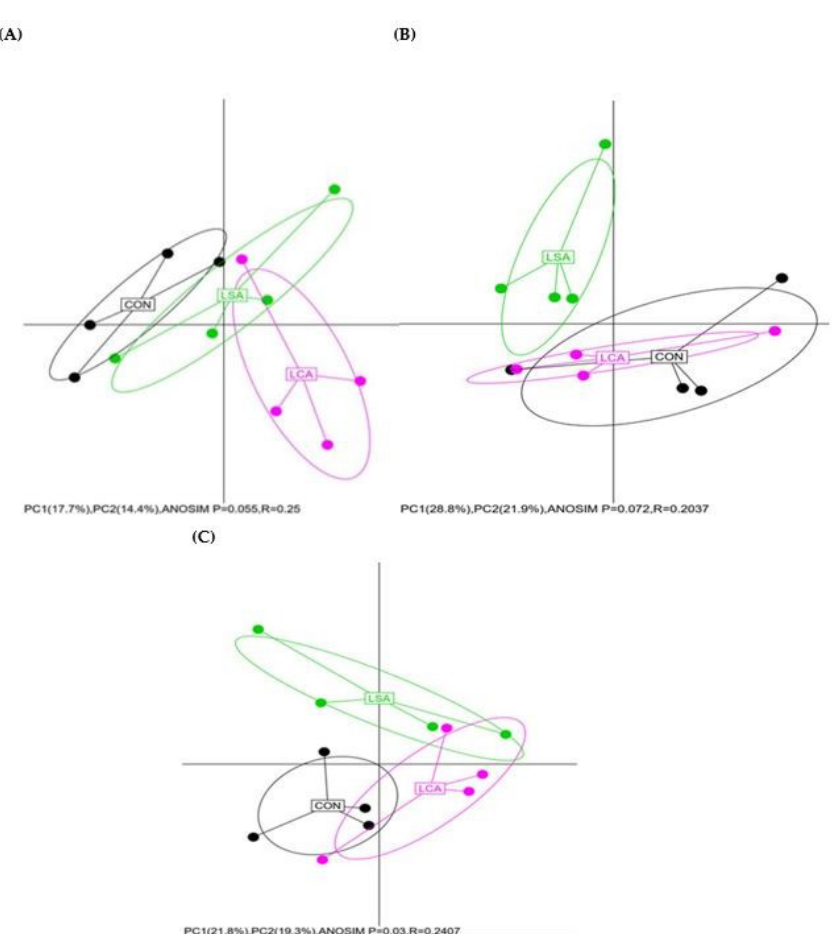
Figure 1. Principal component analysis (PCA) of bacterial community structures in the three treatments of the ileum ( A ), colon ( B ) and rectum ( C ). The percentage of variation explained by the x axis represented by PC1 and the y axis represented by PC2 are indicated in the axis. A = ileum; B = colon and C = rectum. CON = control; LCA = low cocktail of antibiotics concentration; LSA = low concentration of single antibiotic. The percentage of variation explained by PC1 and PC2 are indicated in the axis, and the ellipses represented with 95% confidence. R-values closer to 0 denote groups not significantly different from one another, while values closer to 1 denote a highly different community composition, P value ≤ 0.05 is significantly different.